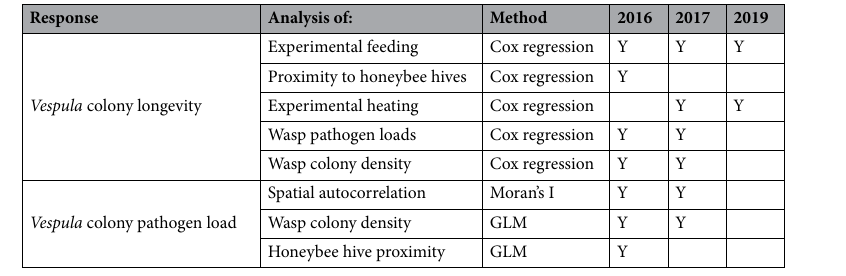
Table 1. Summary of analyses across the three years of